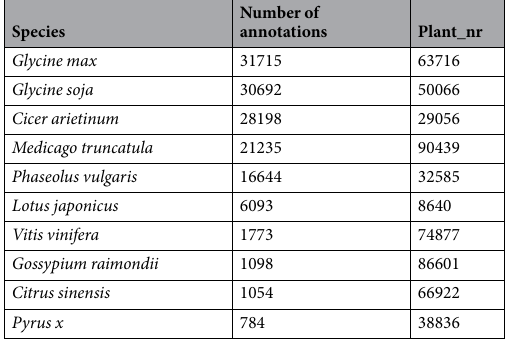
Table 3. The top-10 Blast hits for the assembled unigenes based on NCBI non-redundant (nr) protein database